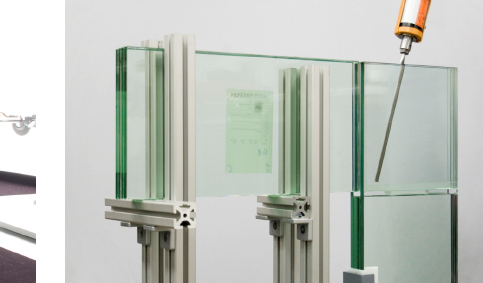
Figure 7: Production studies - application of adhesive to the test specimen with a flat